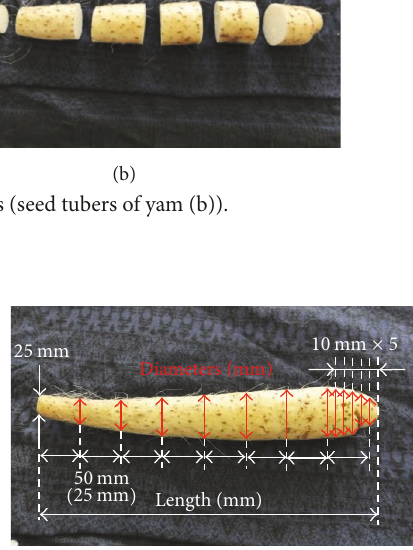
Figure 2: An example of the measurements of a yam: length and diameters. The weight was also observed. All yams were automat- ically cut off at a diameter of 25 mm (the cutoff